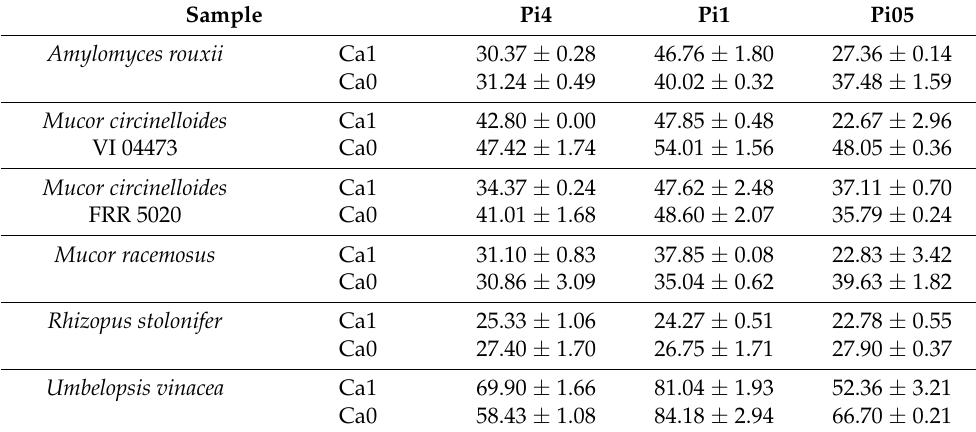
Table 2. Lipid content in % per cell dry weight